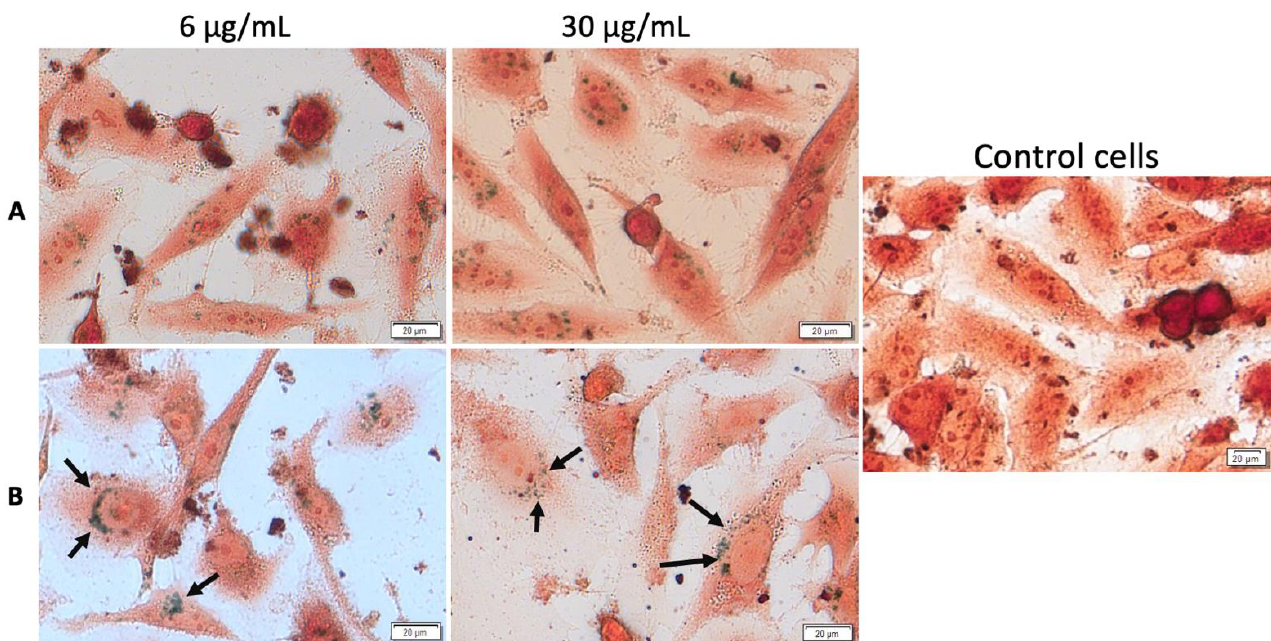
Figure 14. Cellular internalization of MCS inside MDA-MB-231 cells under standard ( A ) and hyperthermic conditions ( B ). The cells were visualized under bright field microscopy at a magnification of 40×. Scale bars represent 20 µm.